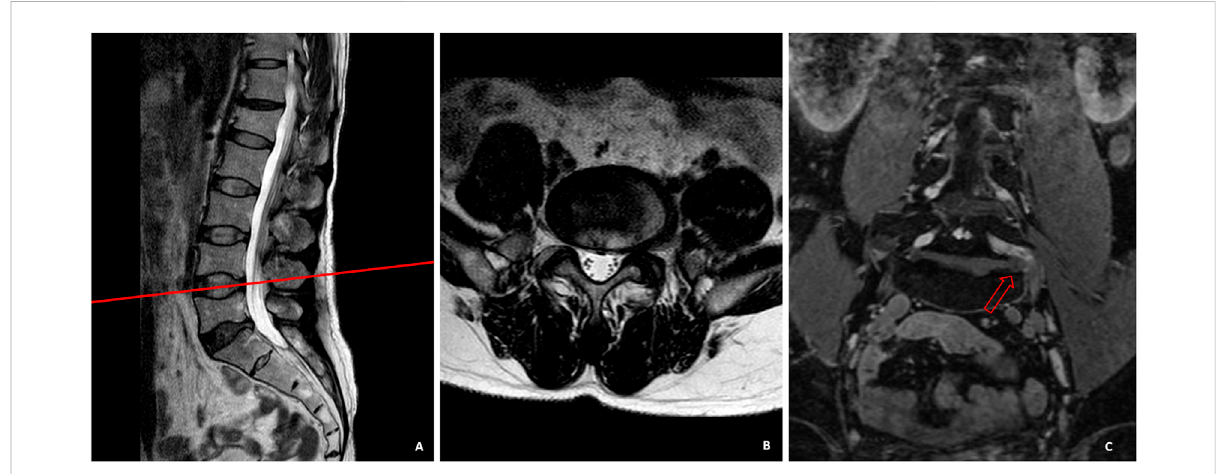
FIGURE 3 In sagittal (A) and cross-sectional (B) MRI, the herniated nucleus pulposus tissues near the intervertebral foramen were easily ignored. The compression of the nucleus pulposus of L4/L5 segment to the left L4 nerve root outside the intervertebral foramen could be intuitively observed on the 3D-DESS image (C) .